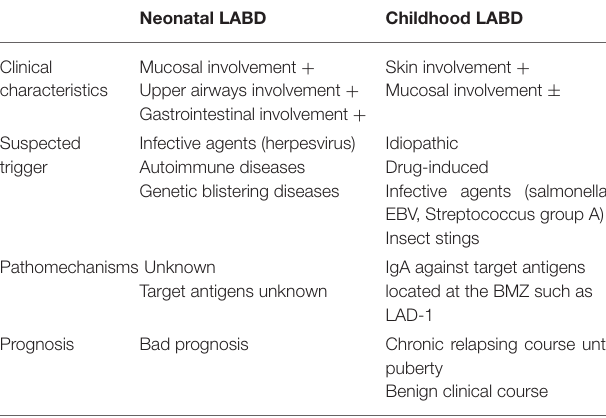
TABLE 4 | Main differential characteristic between neonatal and childhood